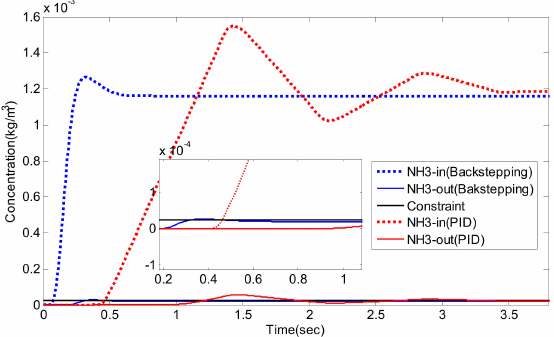
Figure 21. NO / NO 2 = 2 / 1, NH 3 concentration before and after the SCR system.